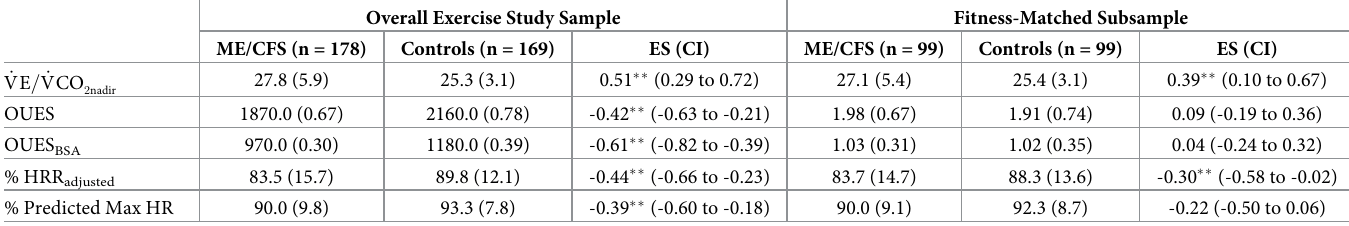
the small to moderate range. In addition, participants with ME/CFS had higher tidal volume compared with controls ( p < 0.05). Ventilatory efficiency. Measures of ventilatory efficiency and HR performance are shown in Table 3. Compared with controls, participants with ME/CFS had moderately and signifi- cantly ( p < 0.05) lower ventilatory efficiency, as demonstrated by a higher _ VE = _ VCO lower OUES. They also demonstrated lower HR performance as demonstrated by lower % HRR, and % predicted max HR. In the fitness-matched sub-sample, the OUES and % pre- dicted max HR were no longer significant ( p < 0.05), but significant differences ( p < 0.05) remained for the _ VE = _ VCO and %HRR. 2 nadir Peak. Cardiopulmonary responses at peak exercise are shown in Table 4. Compared with controls, participants with ME/CFS had significantly ( p < 0.05) lower peak _ VO HR, O pulse, CTI, Watts, Time, and Lactate and significantly ( p < 0.05) higher _ VE = VO 2 Table 3. CPET variables of ventilatory and heart rate performance during exercise testing in ME/CFS patients and controls. Overall Exercise Study Sample Fitness-Matched